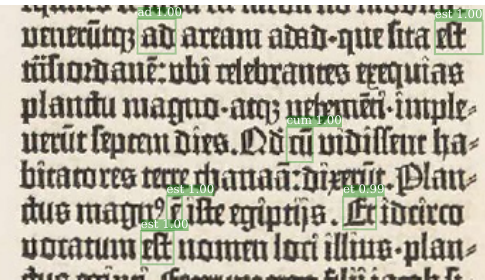
Figure 3. Keyword spotting in a fragment of Gutenberg’s Bible